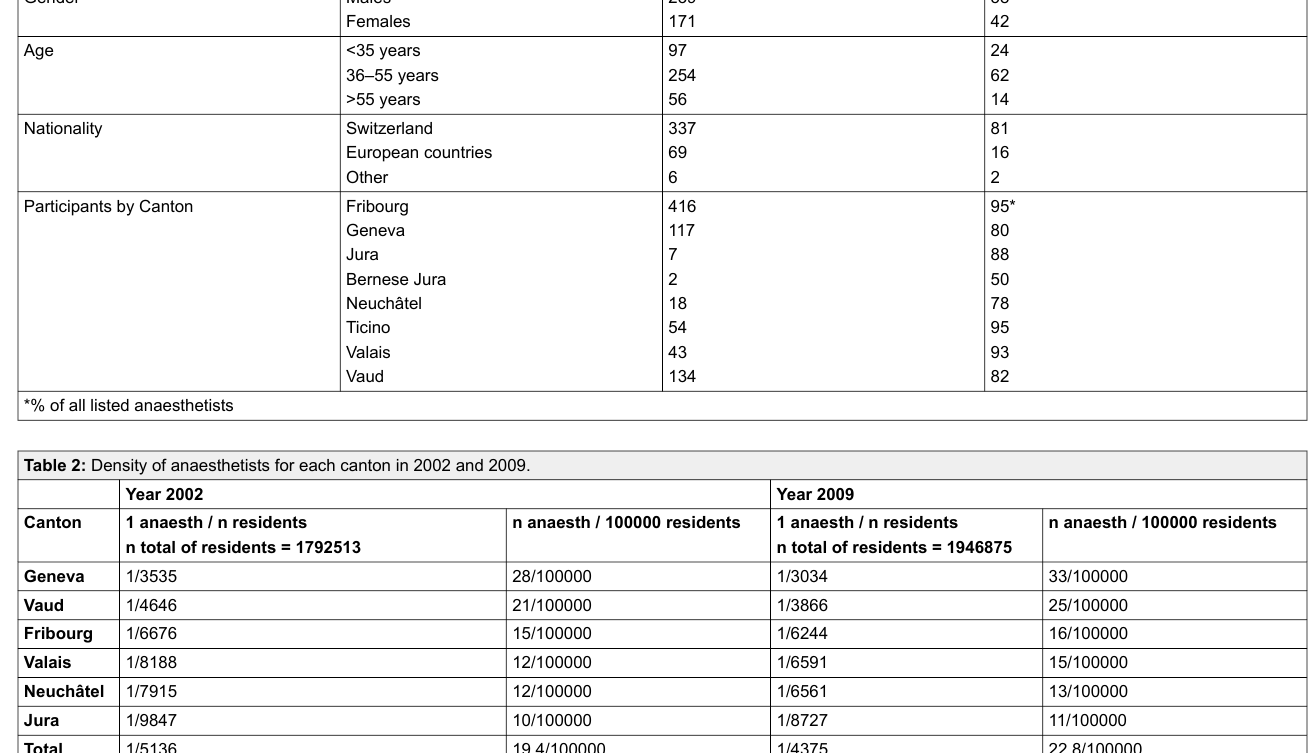
Table 1: Demographic characteristics of participants. Variables